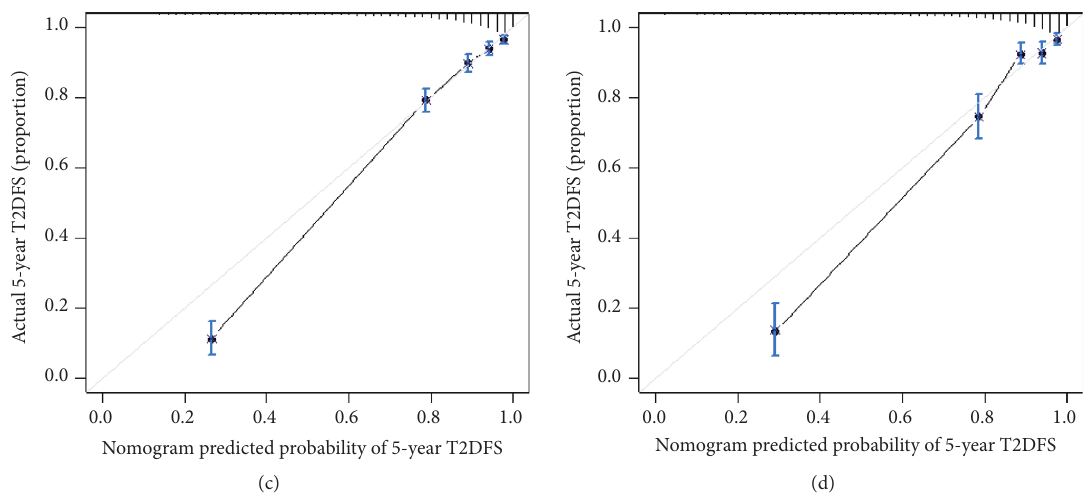
Figure 4: Calibration curves of the nomogram prediction in the study. The observed T2DFS is shown compared with the nomogram at 3years (a) and 5years (c) using the training set and validation set (b and d), respectively. Notes: the x -axis represents the predicted T2DFS probability. The y -axis represents the actual identified subjects with T2DFS. The diagonal gray line represents a perfect prediction by an ideal model. The solid line represents the performance of the nomogram, of which a closer fit to the diagonal gray line represents a better prediction.